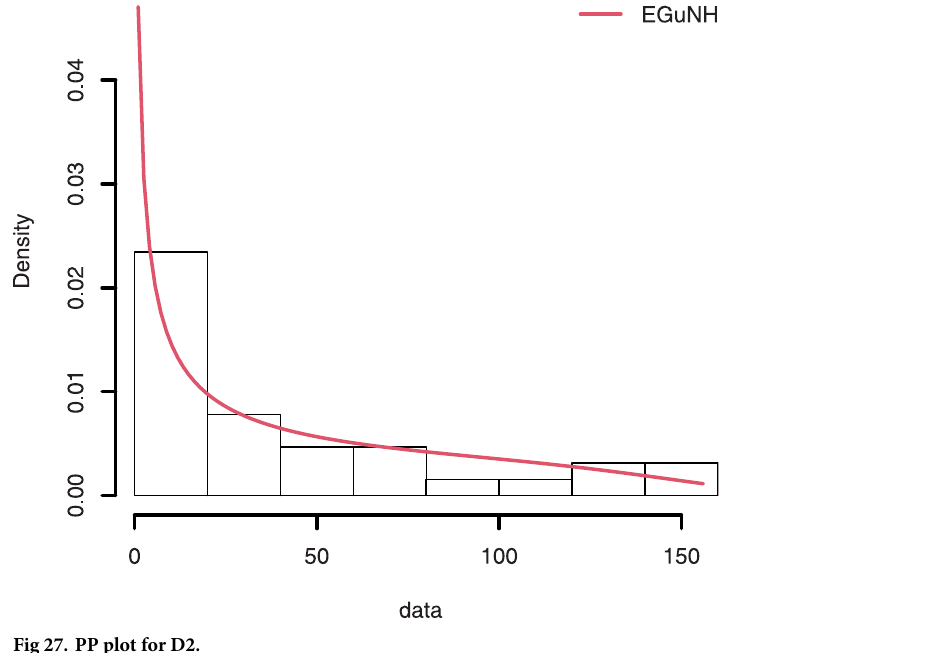
Fig 27. PP plot for D2.